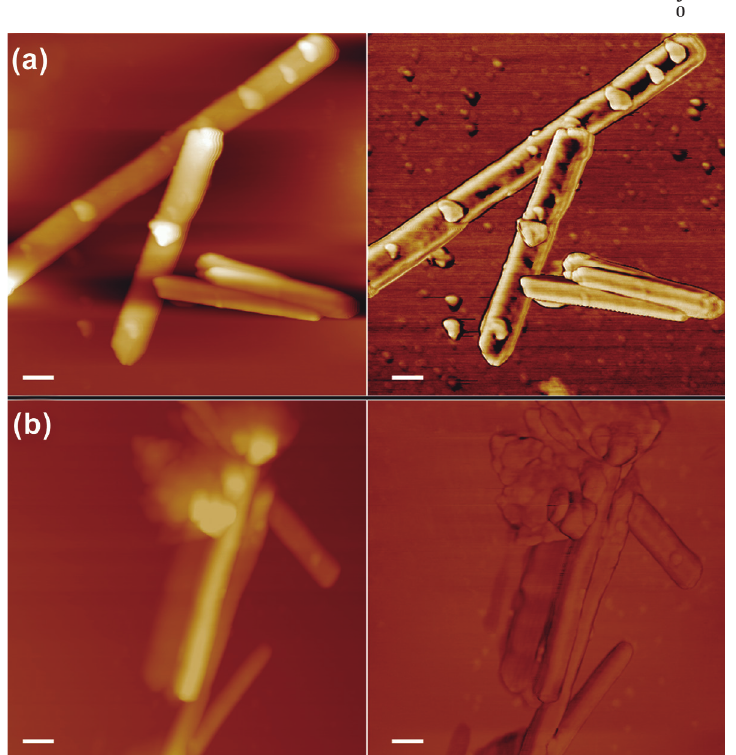
Figure 1- Tapping mode AFM images of enamel crystals on a mica surface, imaged in air. (a) A/J; (b) 129P3/J. Weanling animals had the free access to deionized water and low-F diet until age 12 weeks. Image sizes, 1x1 µm; bar=100 nm. (a)=left, height image, z range, 100 nm; right, phase image, z range, 107.1°. (b)=left, height image, z range, 120 nm; right, phase image, z range,